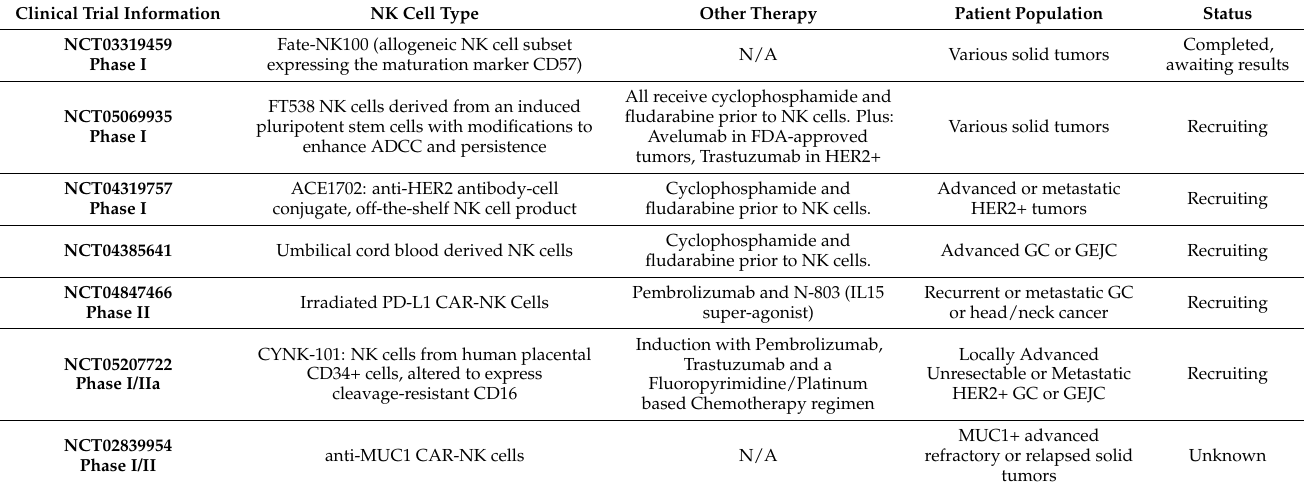
Table 2. Ongoing Clinical Trials Featuring NK Cell Therapy in Gastric Cancer